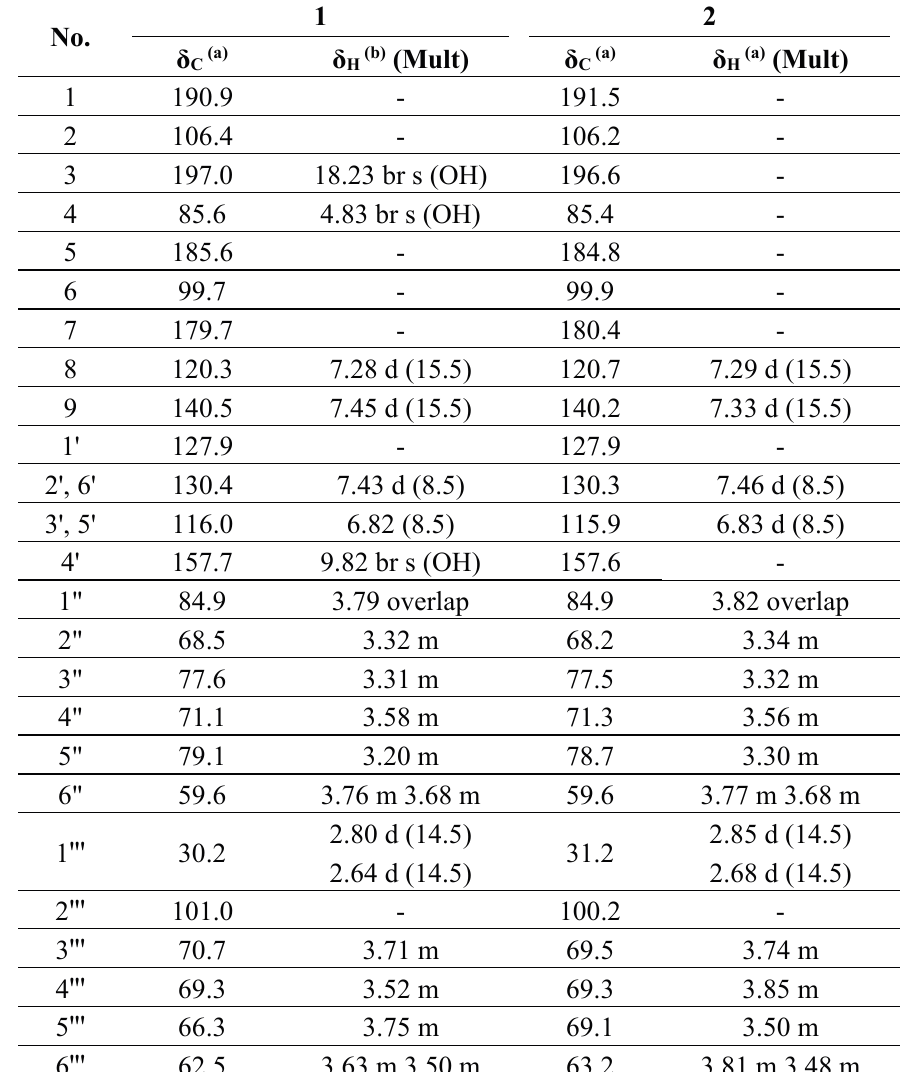
Table 1. 1 H-NMR (100 MHz) and 13 C-NMR (400 MHz) spectroscopic data for compounds 1 and 2 .